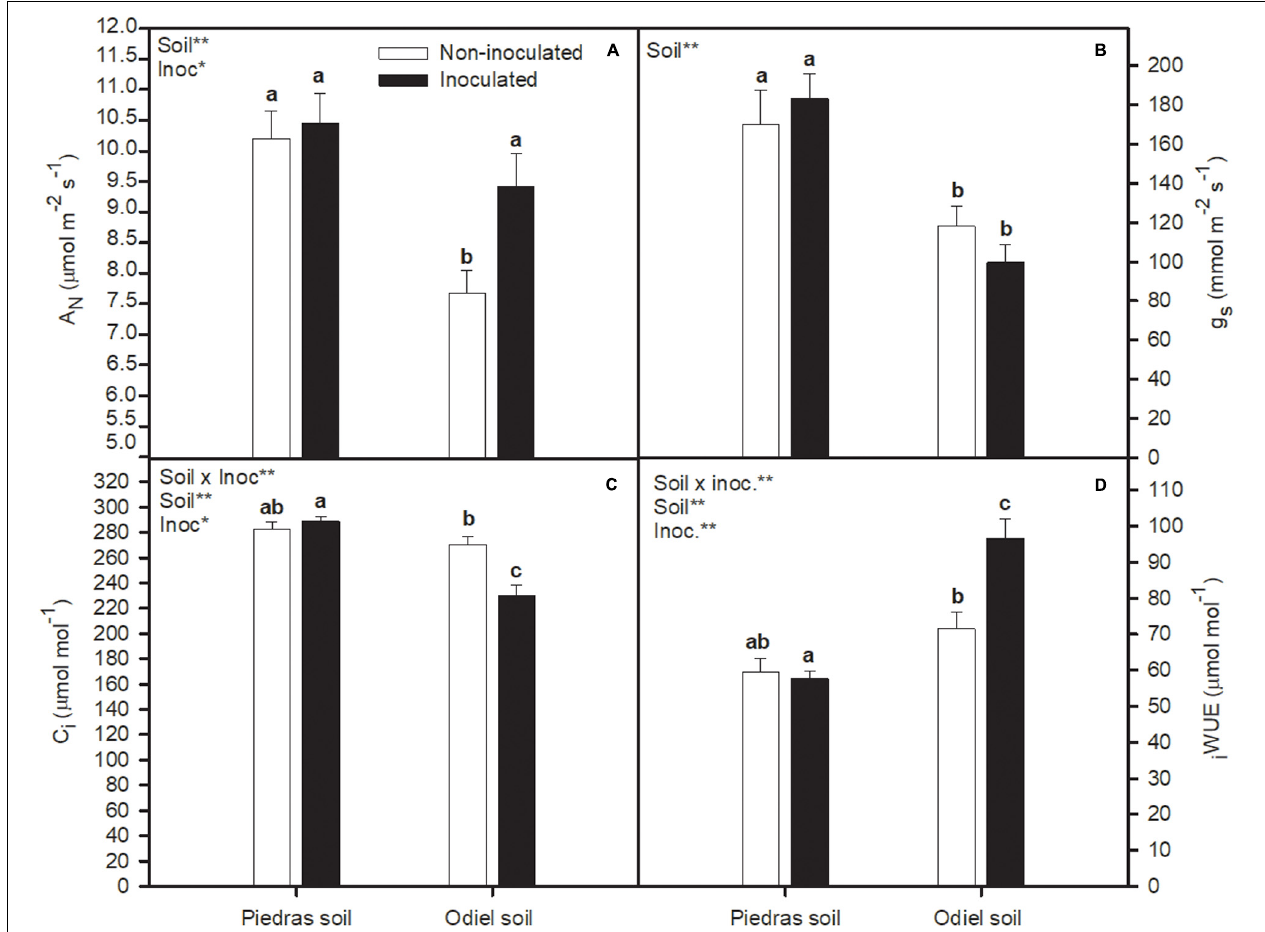
FIGURE 2 | Effect of soil bioaugmentation on S. ramosissima (A) net photosynthetic rate, A N , (B) stomatal conductance, g s , (C) intercellular CO 2 concentration, C i , and (D) instantaneous water-use efficiency, i WUE, after 30 days of treatment. Values are means ± S.E. ( n = 10). “Inoc” or “Soil” in the upper left corner of the panel indicates main or interaction significant effect (* p < 0.1, ** p < 0.01). Different letters indicate means that are significantly different from each other ( p <